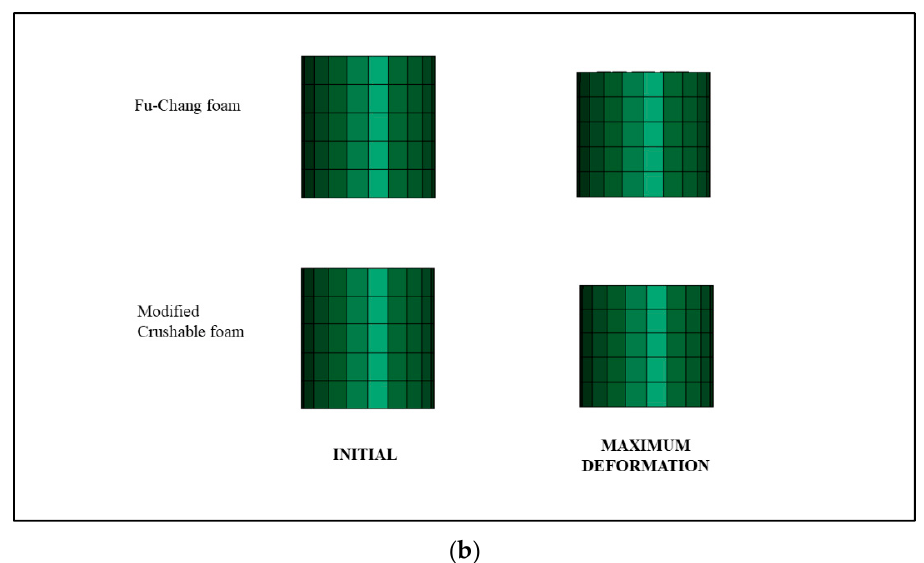
Figure 19. Mode of deformation for jellyroll using Fu-Chang foam and modified crushable foam ( a ) at 20 m/s and ( b ) 30 m/s.